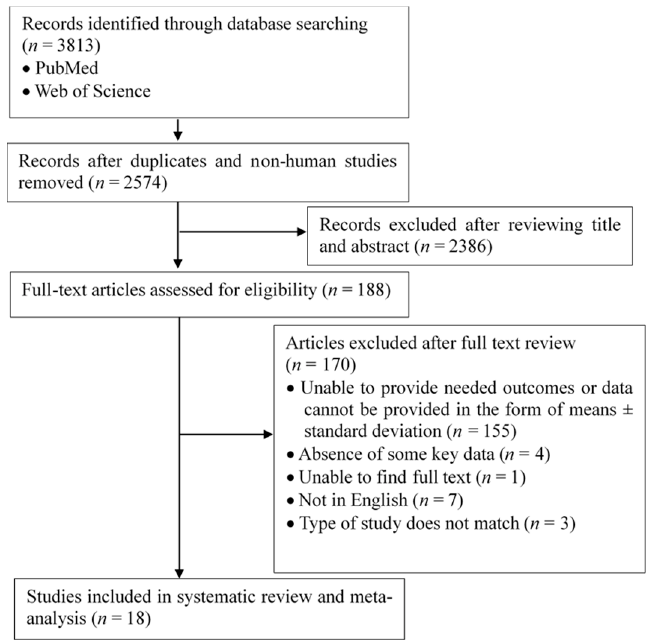
Figure 1. Flow chart of data sourcing and selection.